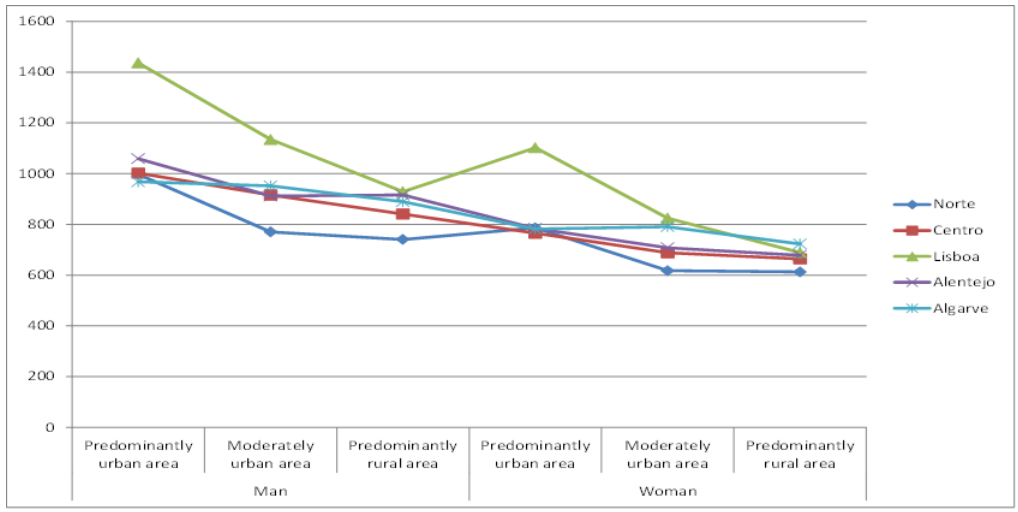
Figure 1. Monthly average earnings (euros) for workers over the period 2004 – 2012, across Portuguese mainland NUTS II, using the gender and the area typology as factors of comparison.